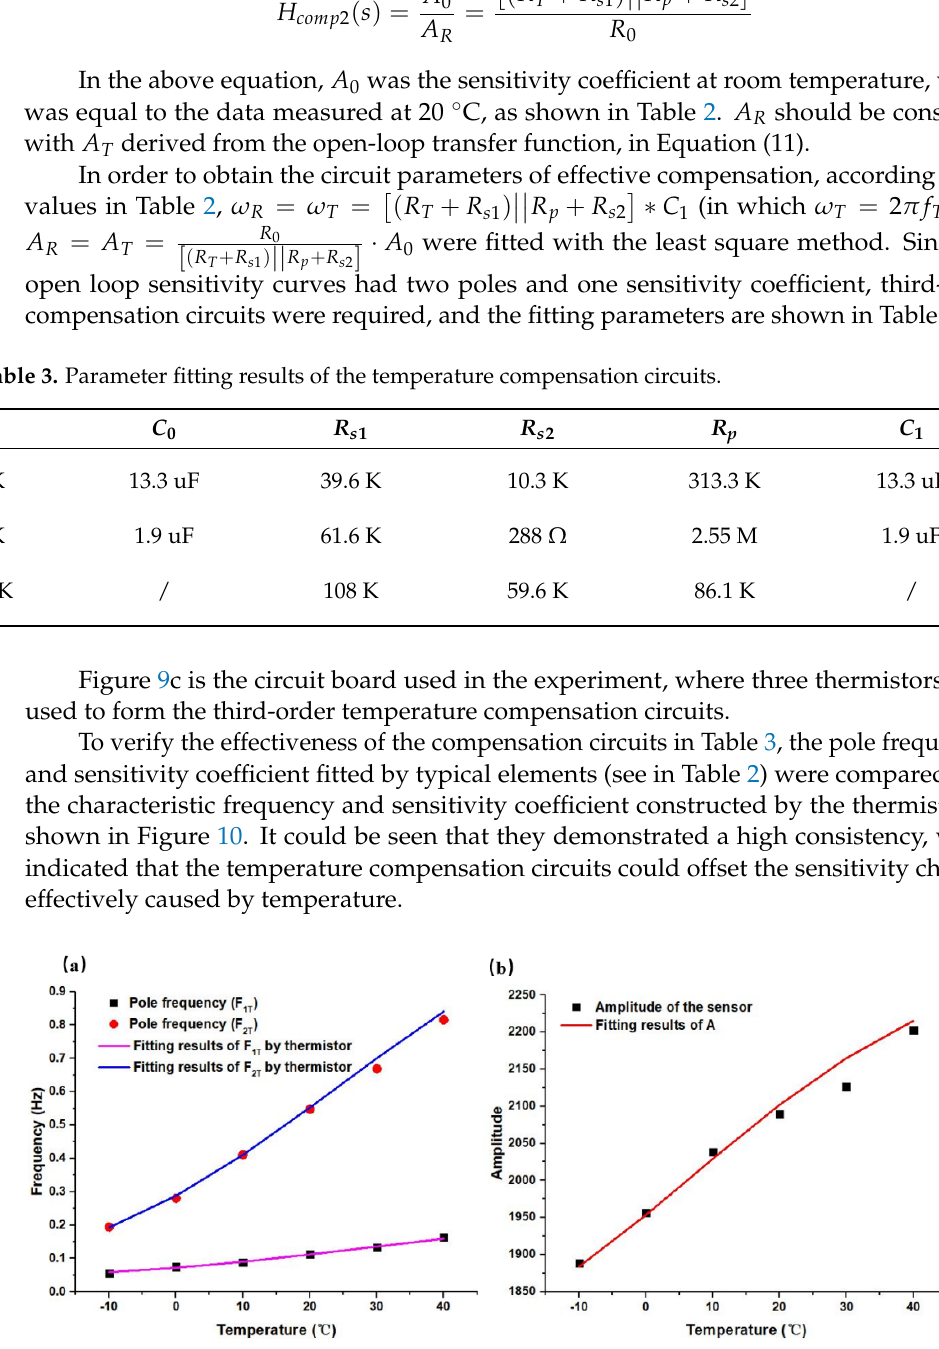
Figure 11. ( a ) Test results for open-loop sensitivity curves after temperature compensation. ( b ) Test results for closed-loop sensitivity curves after temperature compensation. 5. Conclusions This study investigated the temperature characteristics of the open-loop sensitivity curves to find a solution to the sensitivities of the MEMS-based electrochemical seismic sensors, which are greatly affected by temperature. We proposed a mathematical model based on typical elements and designed the temperature compensation method based on thermistors. The results showed that this method had a significant effect and realized real- time temperature compensation. Author Contributions: Conceptualization, J.W. and D.C.; methodology, C.X.; validation, J.C.; for- mal analysis, W.Q.; investigation, B.L.; resources, J.W.; data curation, T.L. and X.S.; writing—origi- nal draft preparation, C.X.; writing—review and editing, J.W.; visualization, X.S.; supervision, D.C.; project administration, J.C.; funding acquisition, J.W. and D.C. All authors have read and agreed to the published version of the manuscript. Funding: This research was funded by the Strategic Priority Research Program (A) of the Chinese Academy of Sciences, grant No. XDA22020302, and the National Science Fund for Distinguished